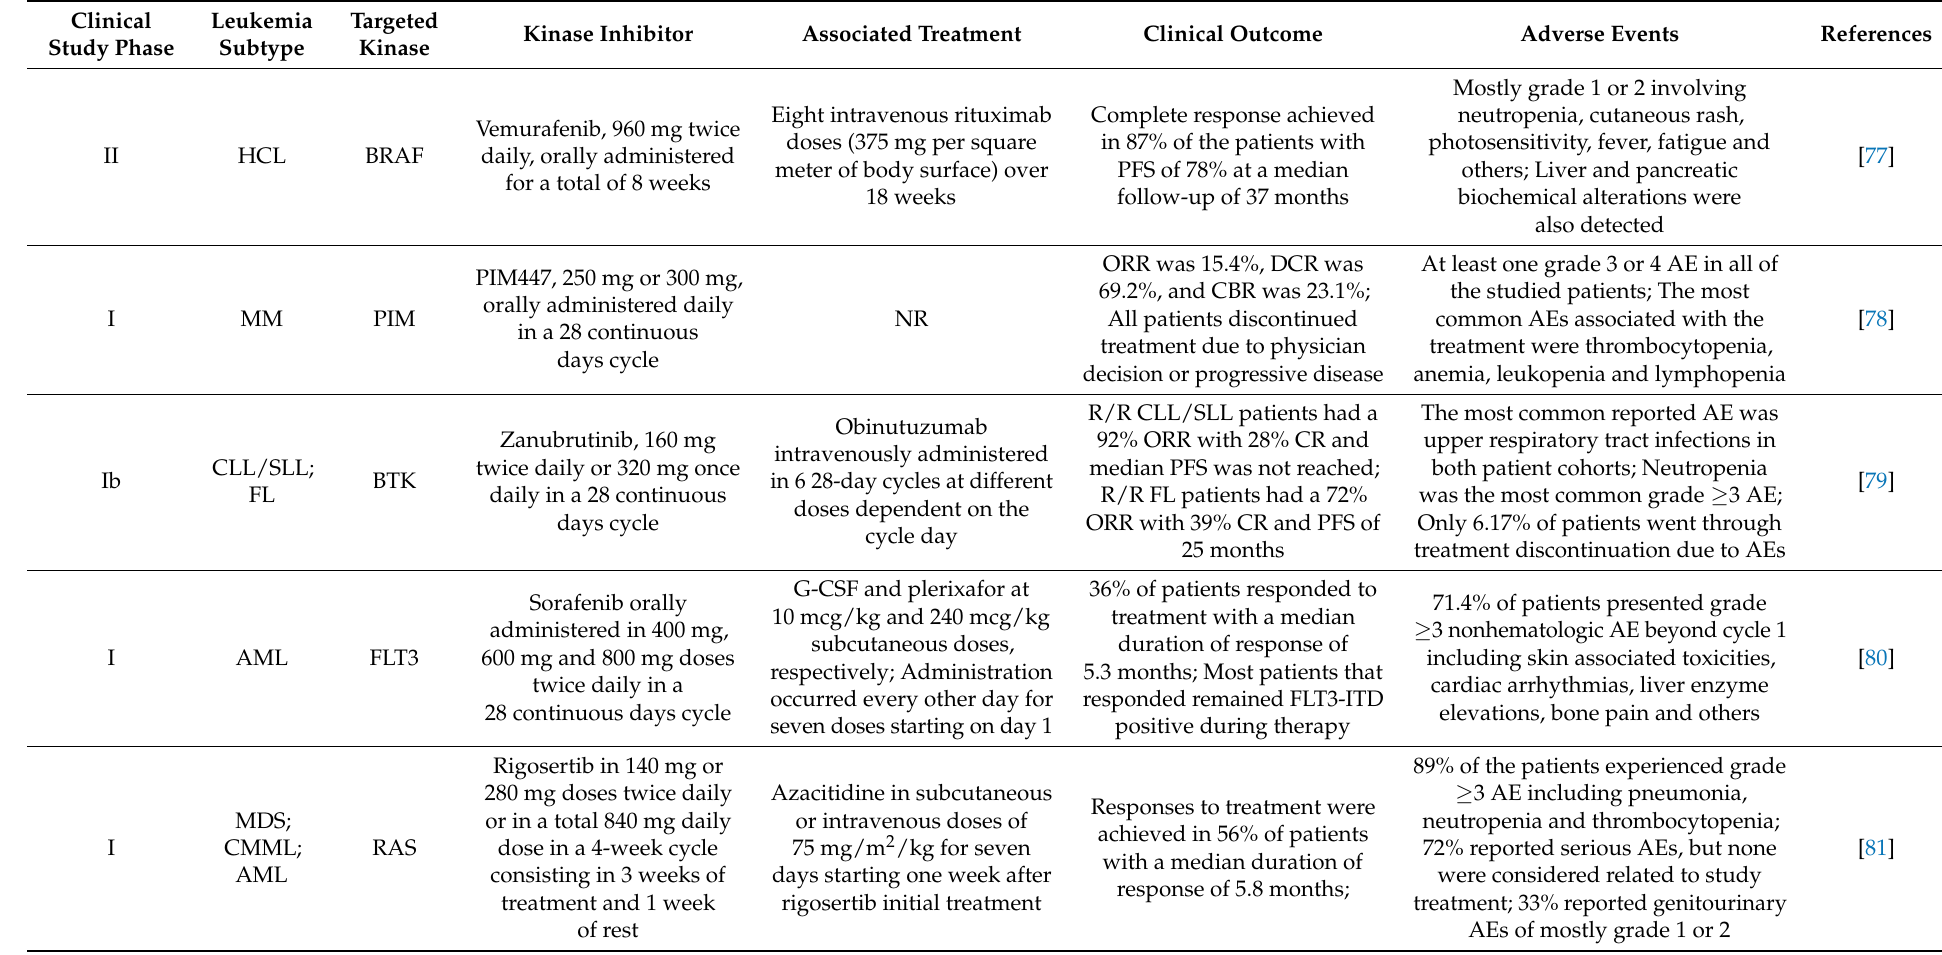
Table 1. Clinical trials utilizing kinase inhibitors (KI) as therapeutics for relapsed/refractory hematological malignancies in the past five